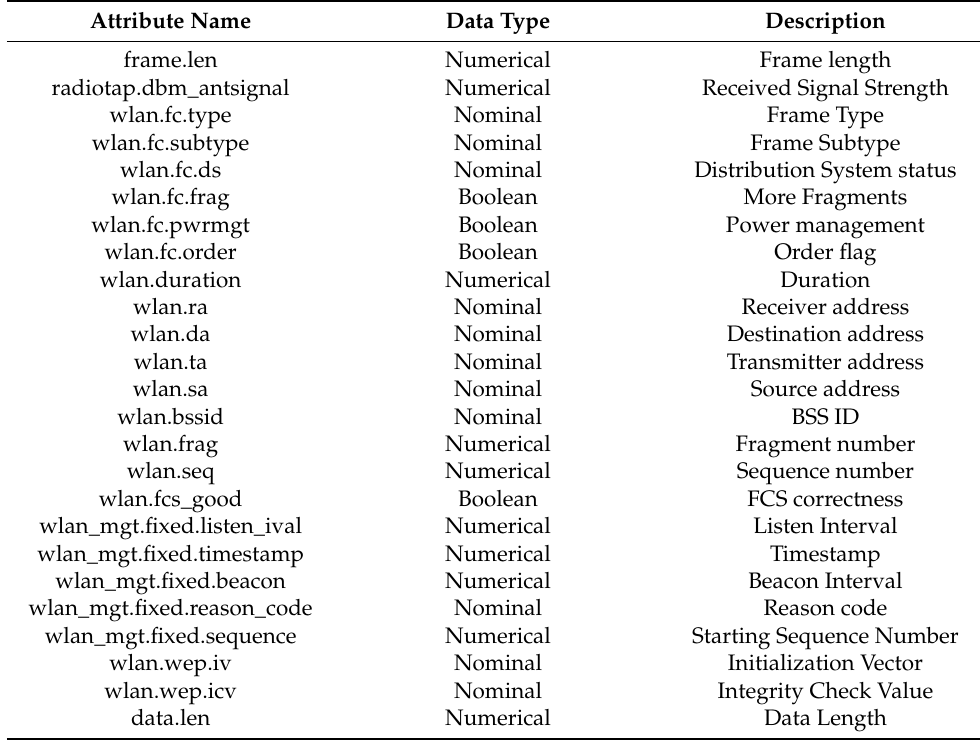
Figure 1. Single instances to graph preprocessing. Table 2. List of packets’